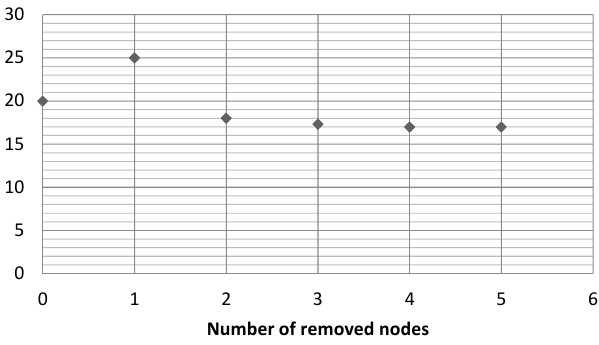
Figure 21. The change of the graph diameter. Table 1. Averaged data from the analysis of the modified graphs.